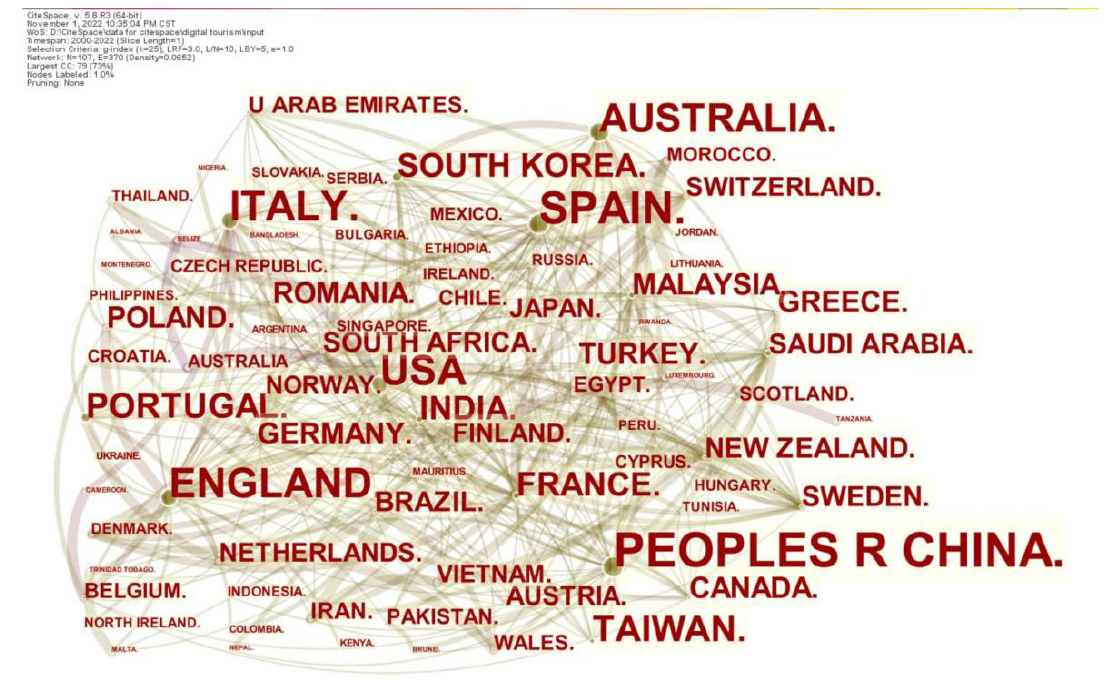
Figure 4. Knowledge map of national cooperation in digital